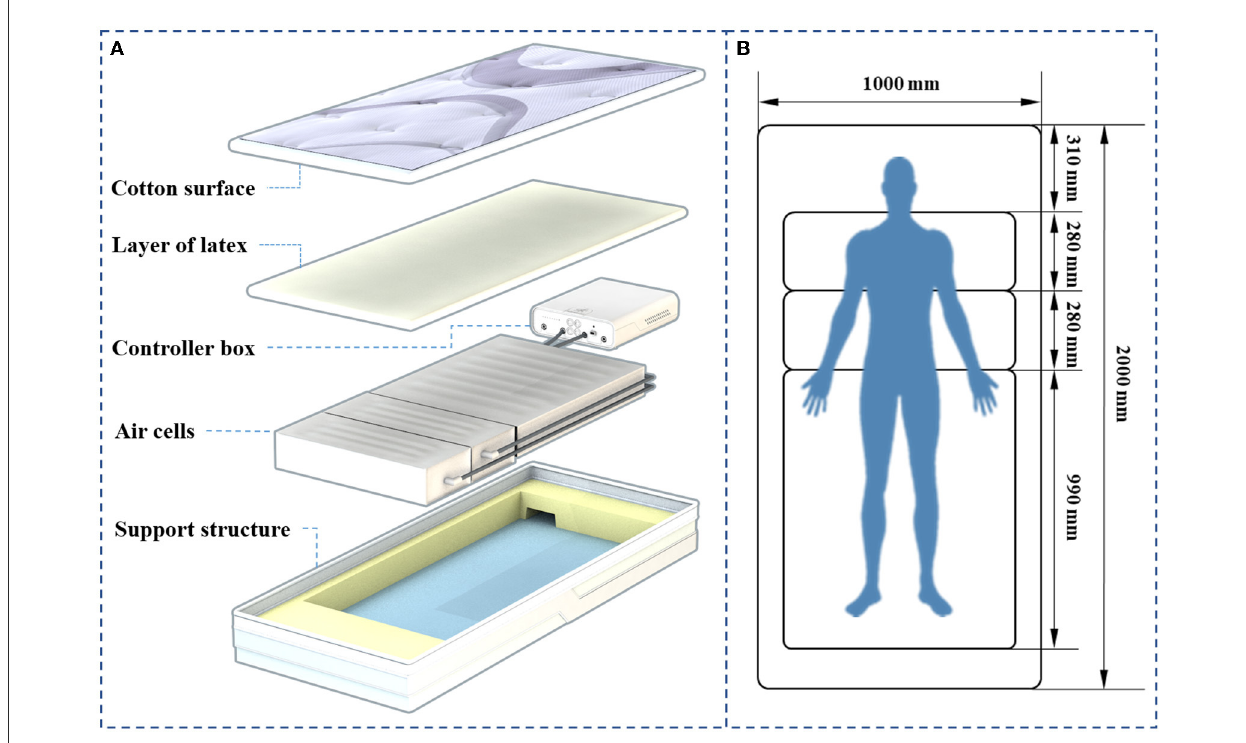
FIGURE1 Structure and size of the auto air mattress. (A) The structure and materials of the auto air mattress. (B) The size of the